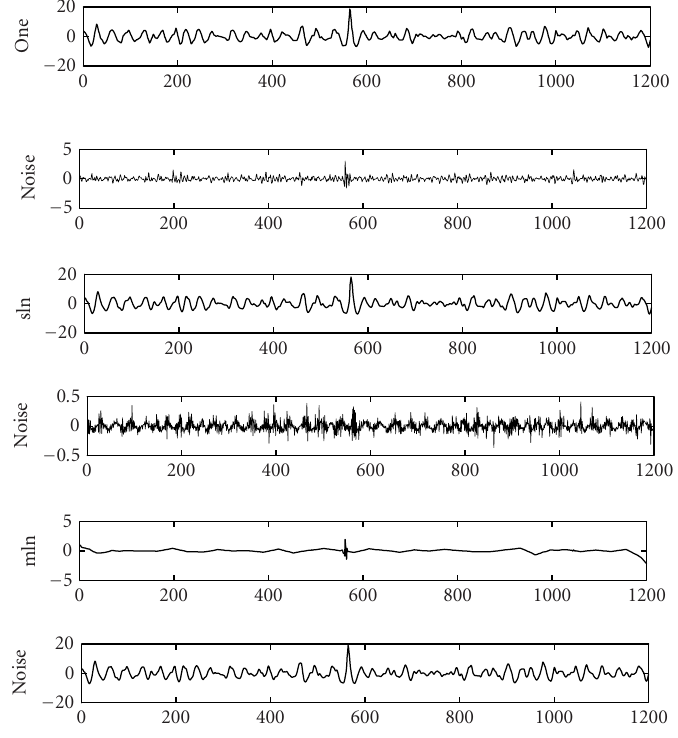
Figure 3.12. Denoised signal/basic /unscaled /nonwhite noise with db3.